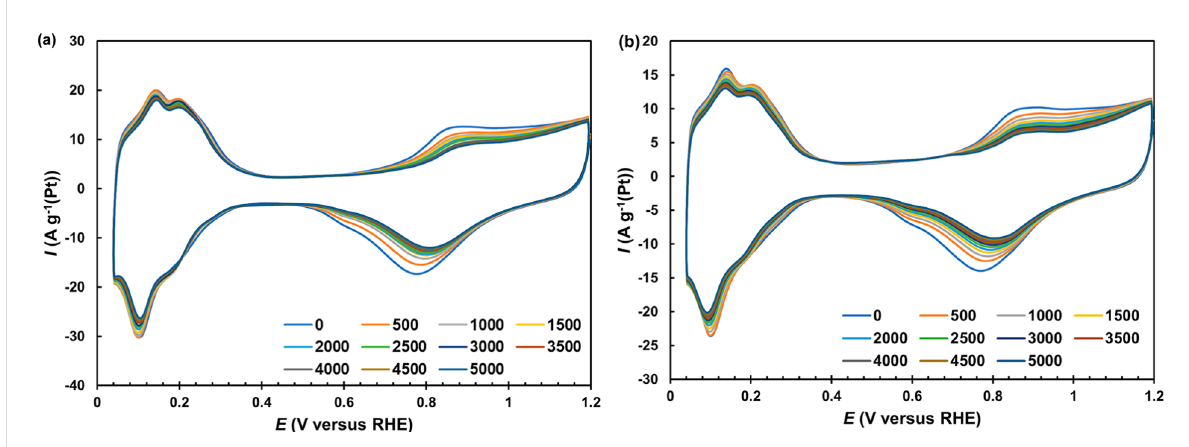
Figure 6: Cyclic voltammograms of (a) G40 and (b) JM40 catalysts measured at a potential sweep rate of 20 mV·s − 1 for every 500 stress test cycles. Electrolyte is 0.1 M HClO 4 , Ar atmosphere.